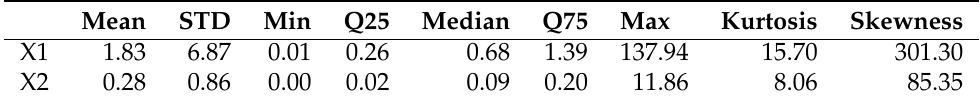
Table 2. Descriptive statistics of property damage and third-party liability costs ( X 1 ) and exceptional medical expenses ( X 2